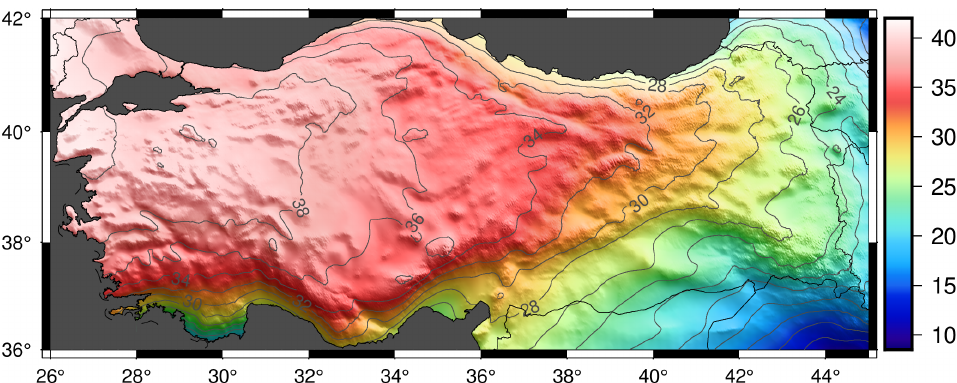
Figure 8. Experimental gravimetric geoid model calculated with mixed global geopotential model as the reference model (expGeoid − 6; Minimum = 8.827 m, Maximum = 41.778 m, Mean = 30.793 m, SD = 6.781